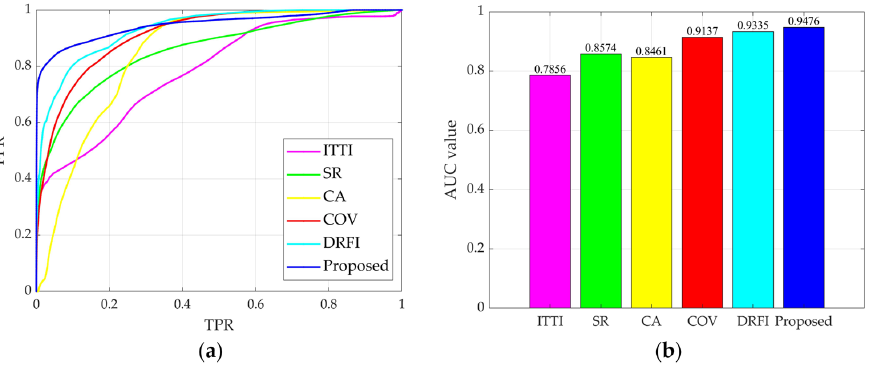
Figure 14. The performance of ROC-AUC among different saliency models. ( a ) ROC curve. ( b ) AUC